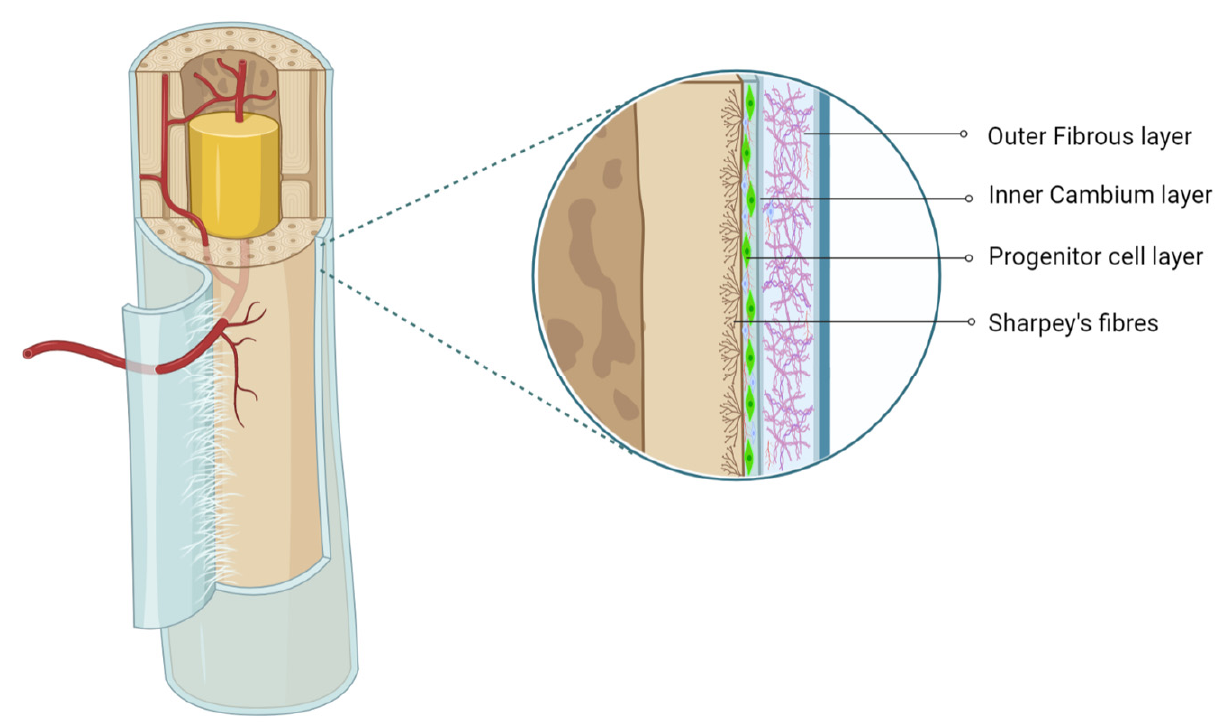
Figure 1. Anatomy of periosteum. Created with BioRender.com.